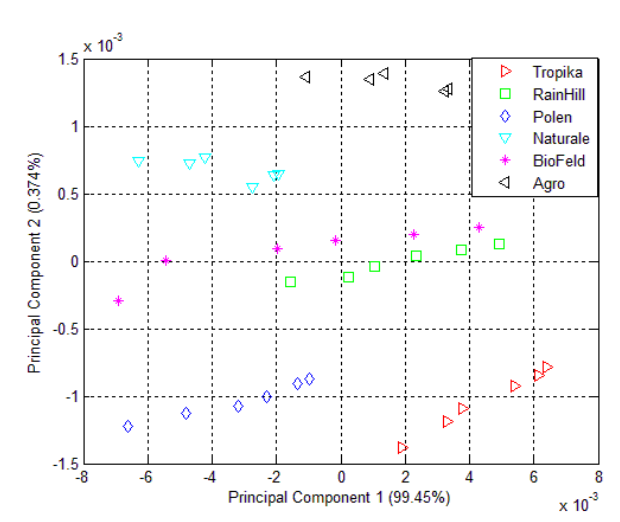
Figure 4. PCA plot of 32 e-nose sensors responses for Orthosiphon stamineus